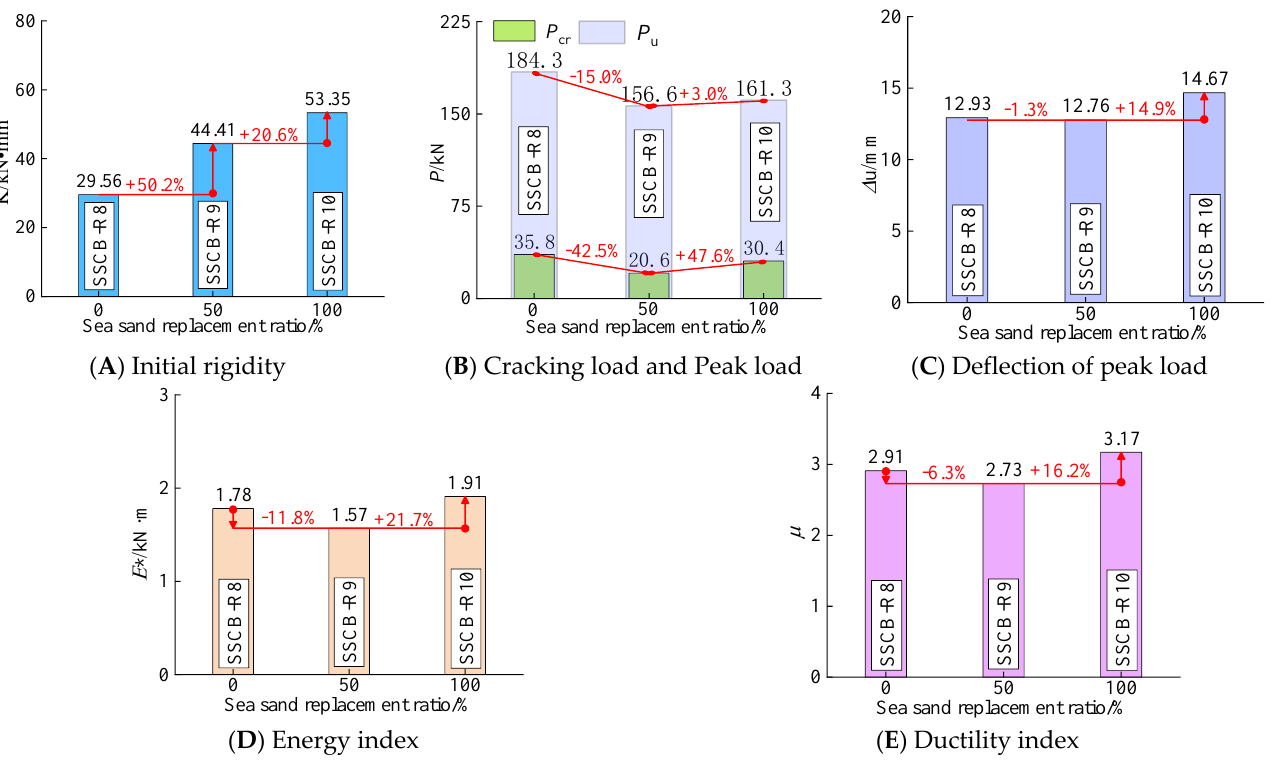
Figure 10. The performance index changes with the replacement rate of sea sand.